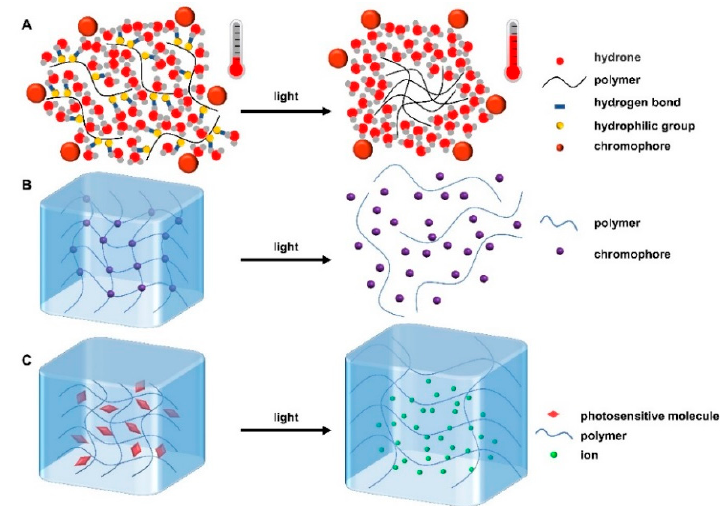
Figure 2. Three gelation mechanisms of photoresponsive hydrogels. When stimulated by light, ( A ) chromophore converts light energy into heat energy, encouraging polymers to aggregate into gels. ( B ) The chromophore structure and properties in the micelles change, causing the hydrogel to become uncrosslinked. ( C ) Photosensitive molecules dissociate, resulting in internal and external osmotic pressure, and causing hydrogel expansion.